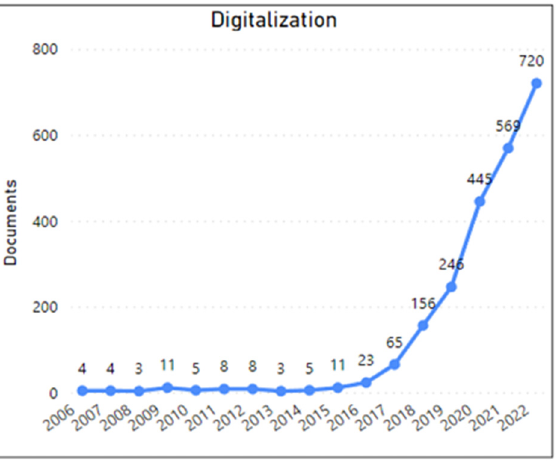
Figure 2. Digitalization—years 2006–2022, 2286 documents in period.